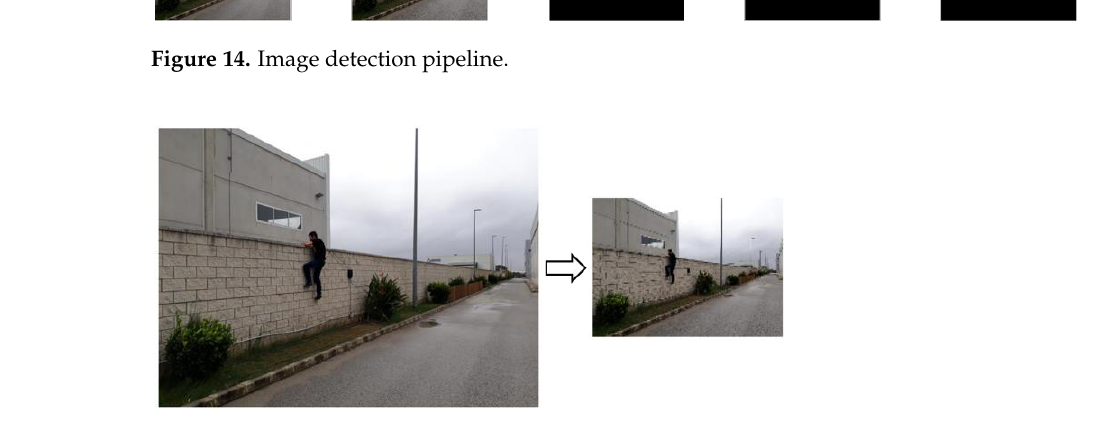
Figure 15. Image detection — preprocessing.